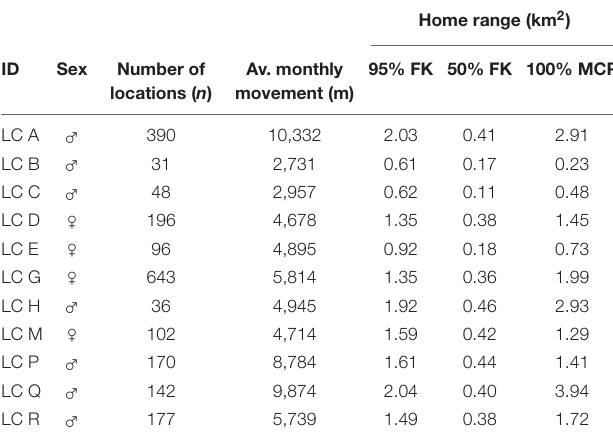
TABLE 2 | The number of recorded location points from each collared leopard cat were used to analyze home range sizes using 100% MCP, 95%FK, 50%FK in the study site, Lada